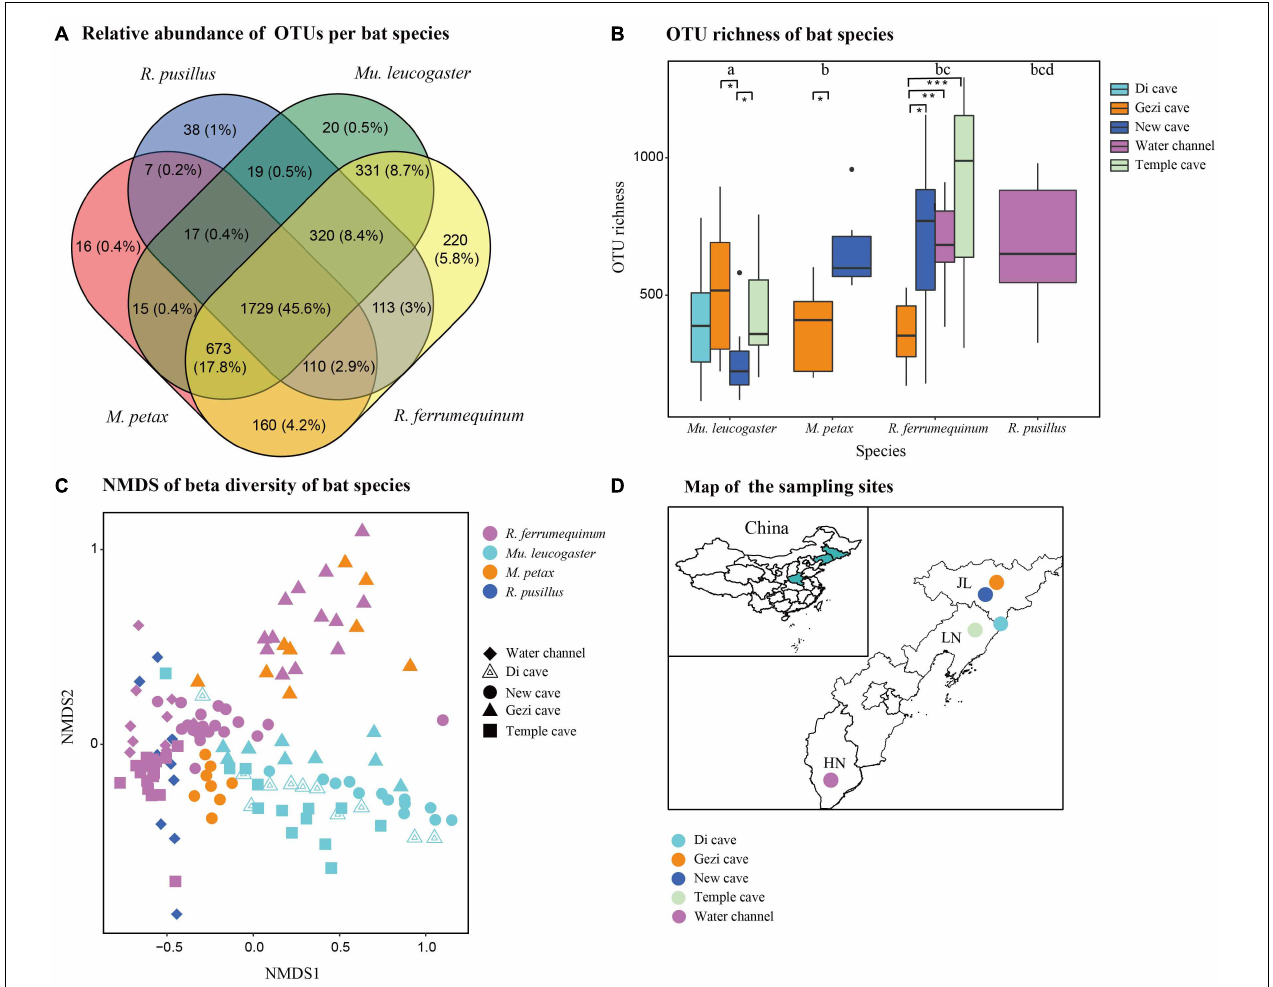
FIGURE 2 | Skin bacterial community structure of four bat species from five sites. (A) Relative abundance of shared and unique Operational Taxonomic Units (OTUs) on each bat species. (B) OTU richness of four bat species. Letters and * represent significant differences among groups. * P < 0.05, ** P < 0.01, *** P < 0.001. (C) Beta diversity of four bat species. Non-metric multidimensional scaling analysis of Bray Curtis distances. (D) Map of the sampling sites in China.